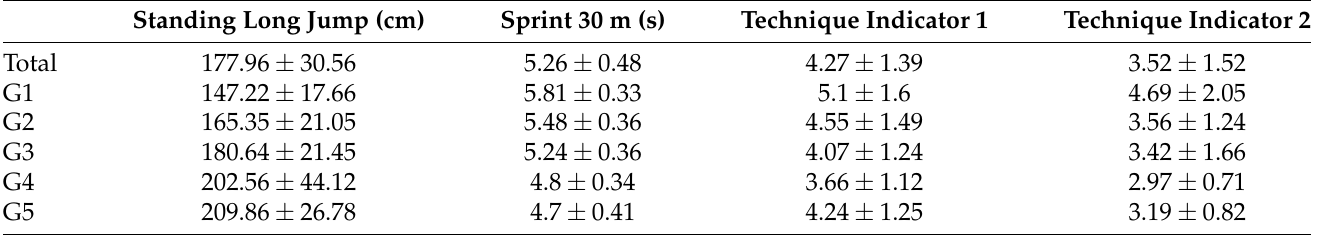
Table 4. Numeral characteristics of physicial fitness test of football